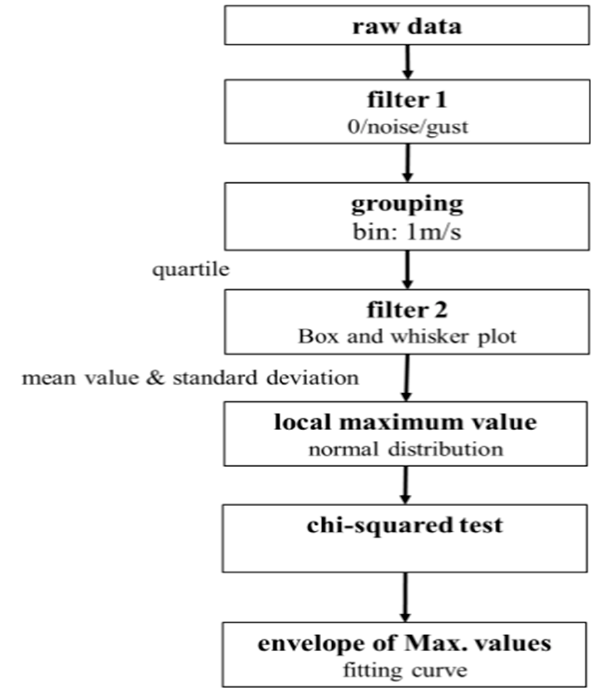
Figure 5. Data processing procedure for wind measurements.